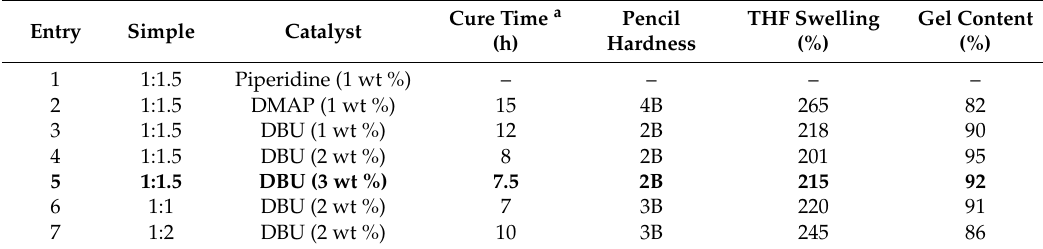
Table 2. Optimization of the curing reaction conditions.